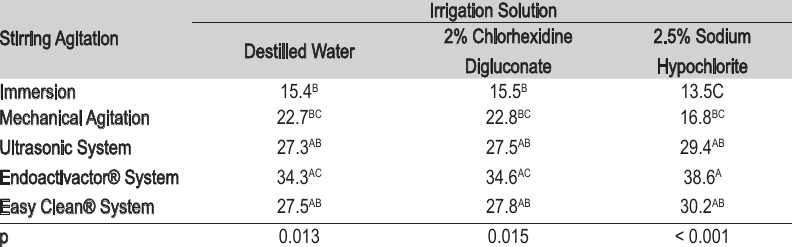
Table 4 - Comparative analysis of the power to dissolve tissue of each irrigating solution for the different agitation